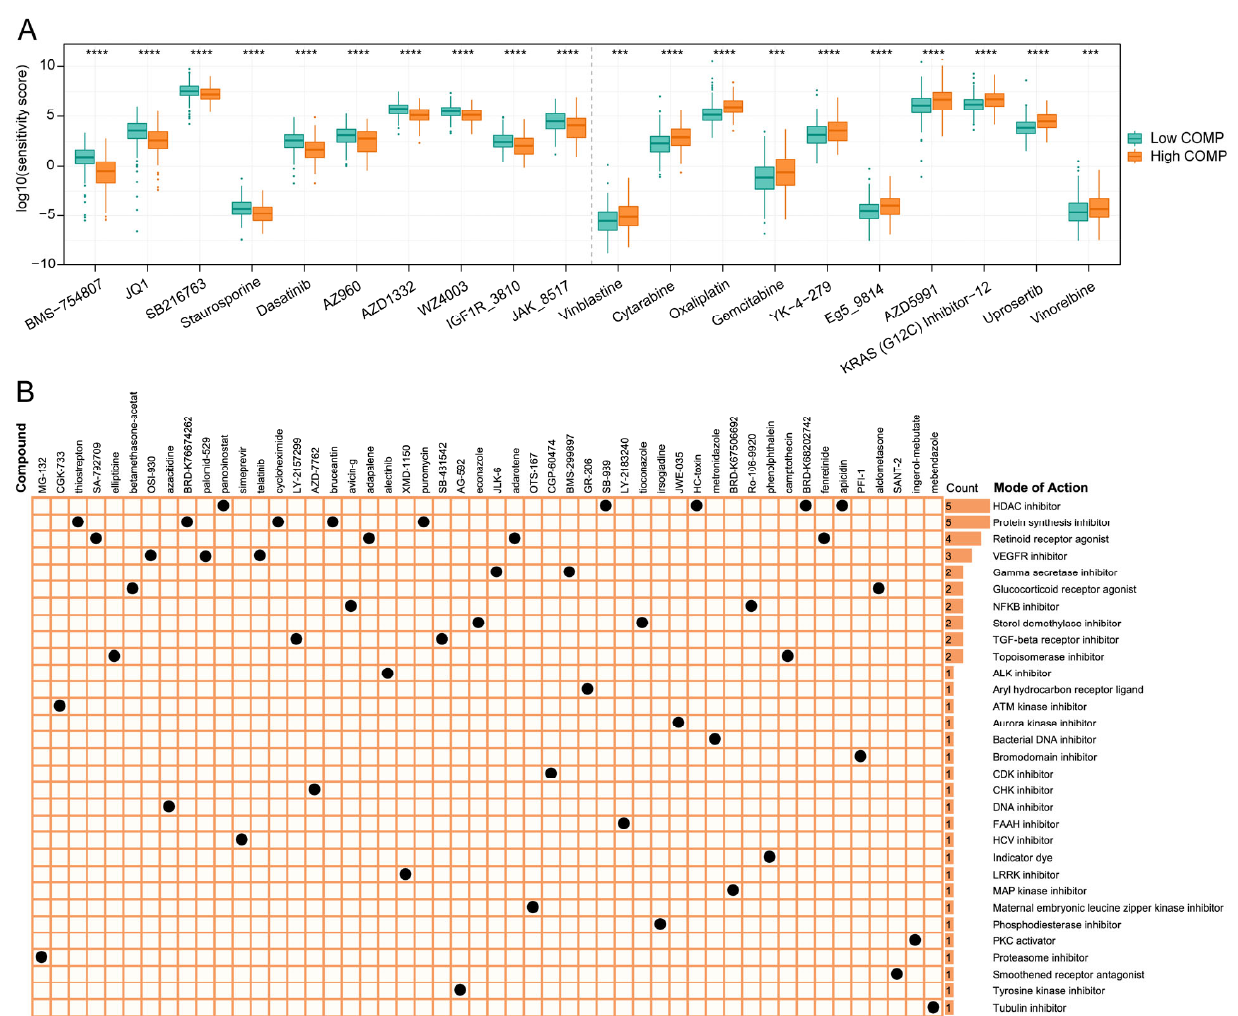
Figure 7. Association between COMP expression and drug sensitivity. ( A ) Predicted sensitivity scores of candidate potent drug for high- and low-COMP expression subgroups (BMS-754807, fold change = 0.437; JQ1, fold change = 0.622; SB216763, fold change = 0.806; Staurosporine, fold change = 0.757; Dasatinib, fold change = 0.624; AZ960, fold change = 0.738; AZD1332, fold change = 0.684; WZ4003, fold change = 0.782; IGF1R_3810, fold change = 0.730; JAK_8517, fold change = 0.767; Vinblastine, fold change = 1.611; Cytarabine, fold change = 1.584, Oxaliplatin, fold change = 1.510; Gemcitabine, fold change = 1.741; YK-4-279, fold change = 1.566; Eg5_9814, fold change = 1.545; AZD5991, fold change = 1.560; KRAS (G12C) Inhibitor-12, fold change = 1.449; Uprosertib, fold change = 1.471; Vinorelbine, fold change = 1.448); ( B ) The heat map displays compounds and their shared MoA based on the CMap database (*** p < 0.001; **** p < 0.0001). Table 1. Correlation between COMP expression and pathological parameters in colon cancer.